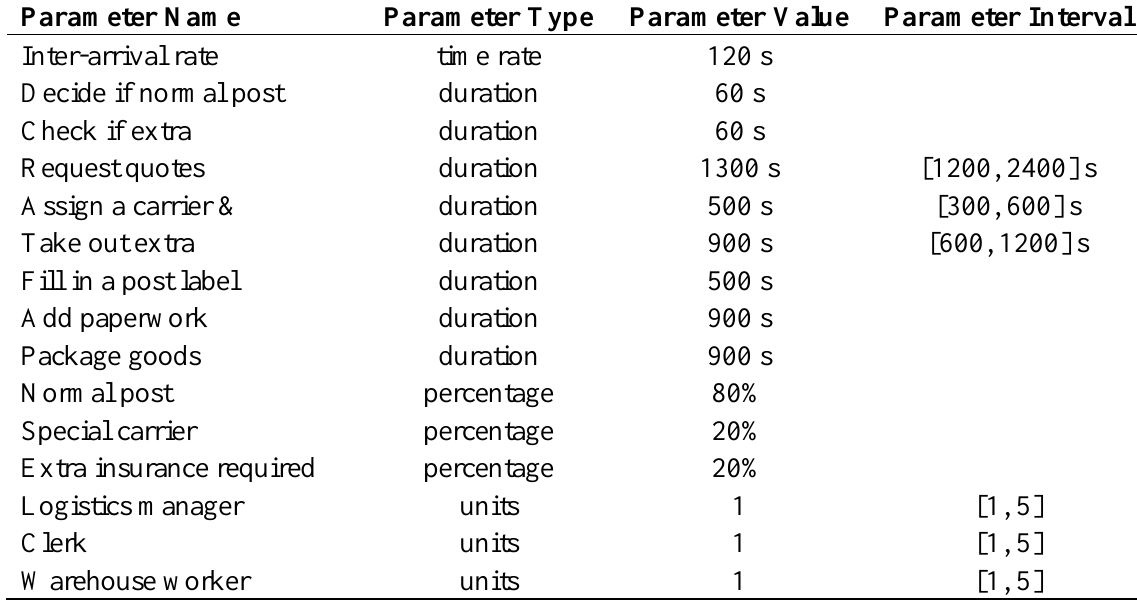
Table 5. Parameters and their values for the shipment scenario.